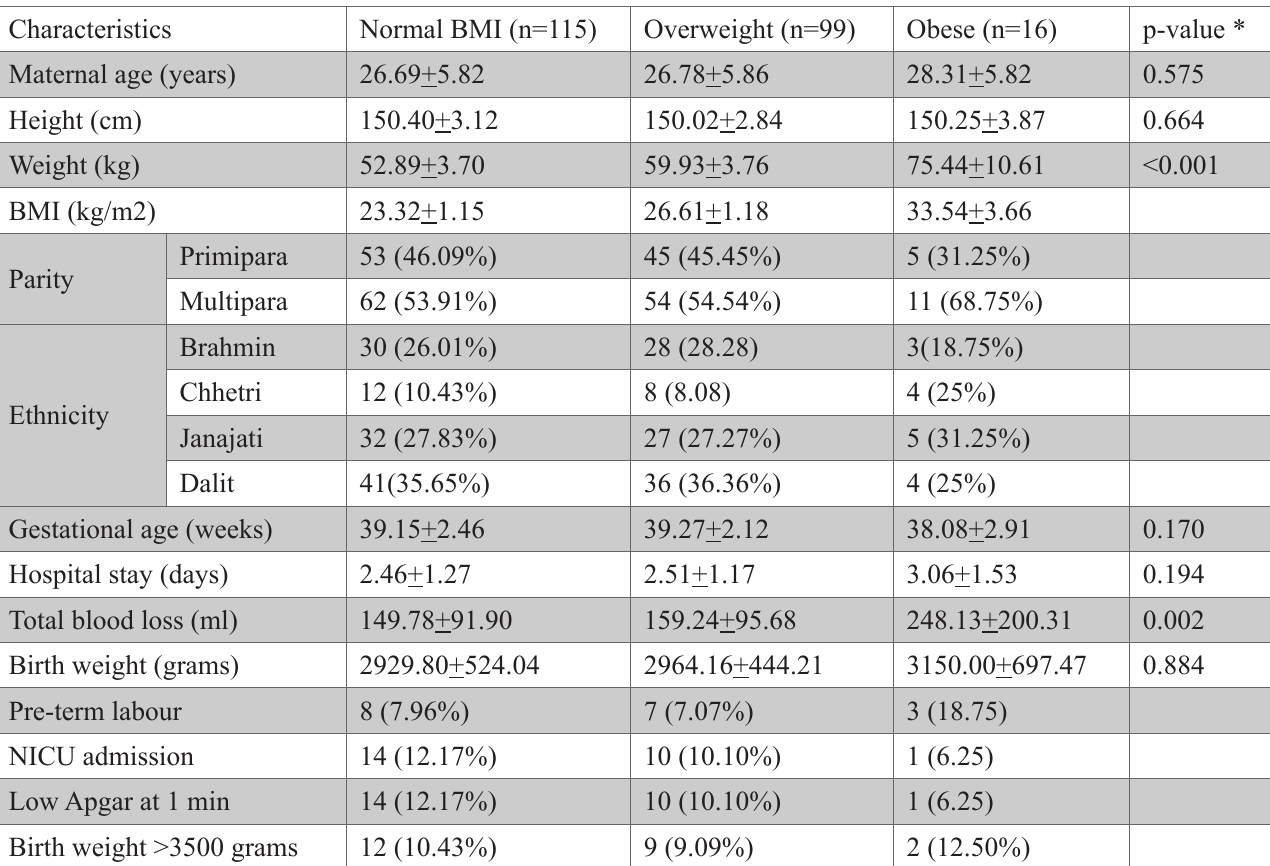
Table 1: Socio-demographic and clinical characteristics of the normal BMI, overweight and obese groups